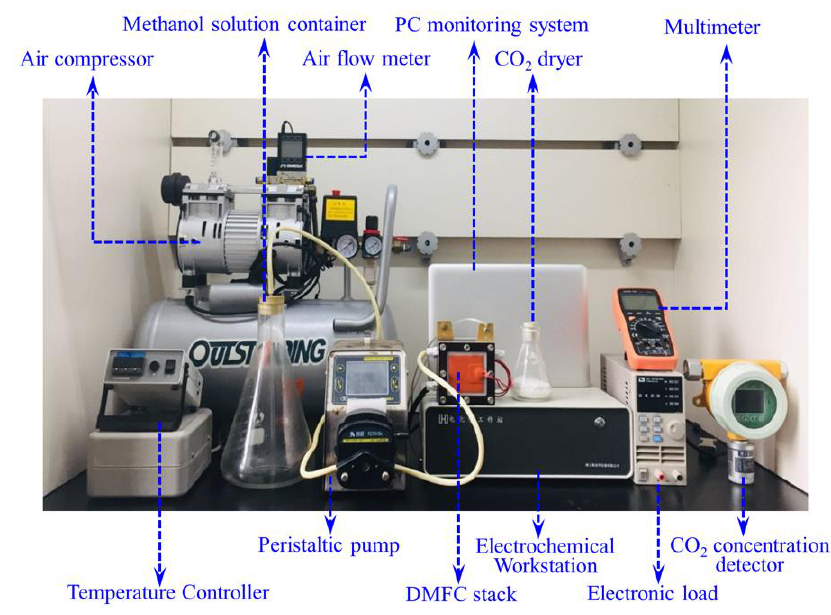
Figure 1. The experimental platform of DMFC systems.